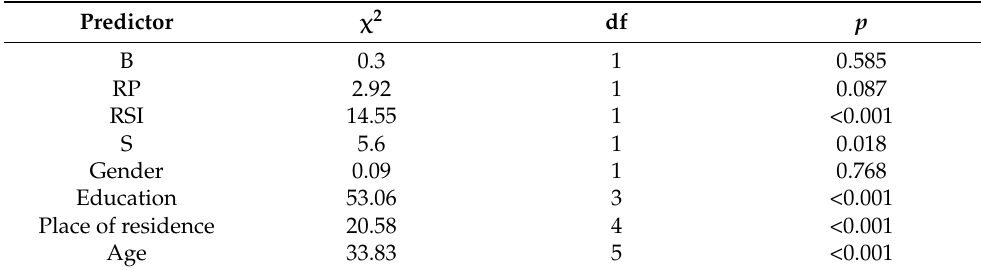
Table 5. Omnibus Likelihood Ratio